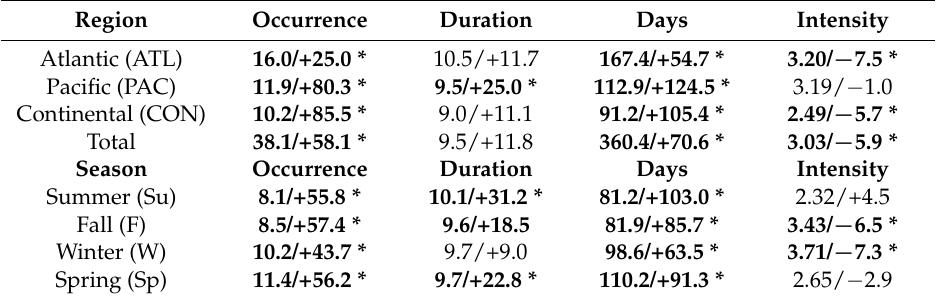
Table 2. Character of NH blocking events per year as a function of region and season for all characteristics since the study of [1], and percent change in the value as compared to [1]. Bold values are statistically significant at the 90% confidence level and those with a (*) are statistically significant at the 95% confidence level or